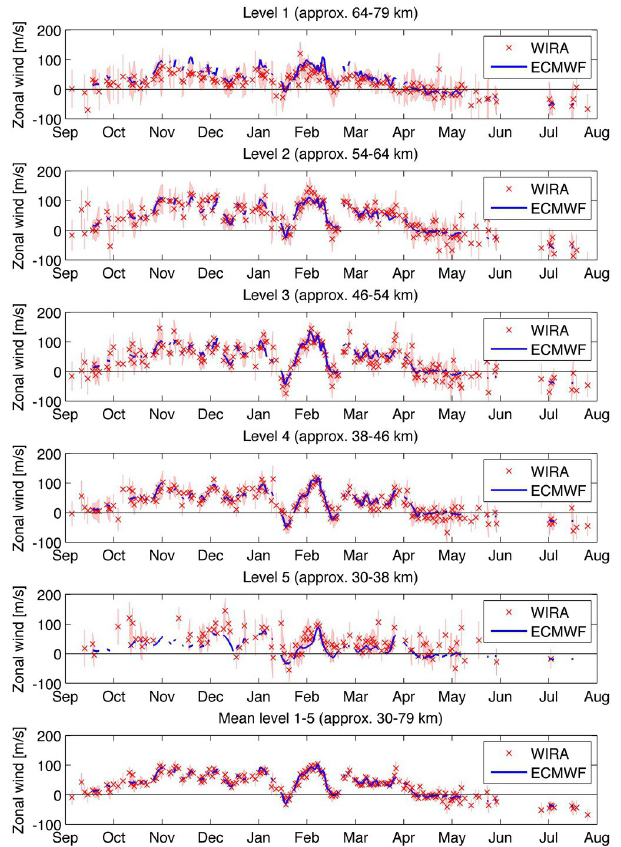
Fig. 11. Comparison of the data series from WIRA retrieved with the mirror method to the ECMWF operational analysis data for the standard WIRA levels and the mean over these altitude ranges. The data points are daily average winds. The 1 σ -uncertainties are indi- cated by error bars.